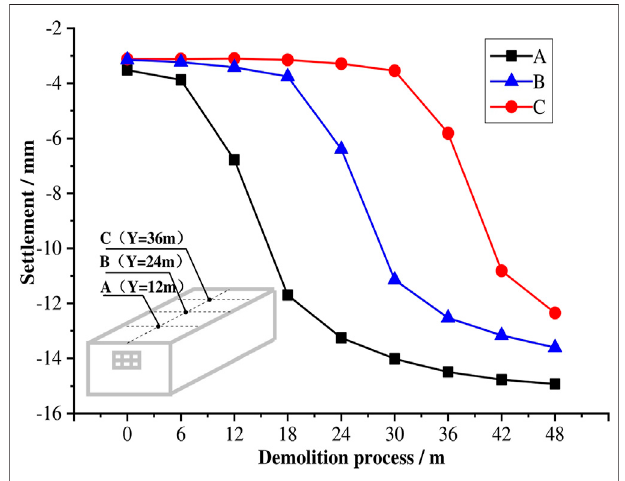
FIGURE 4 | Surface settlement during the dismantling process of temporary lining.